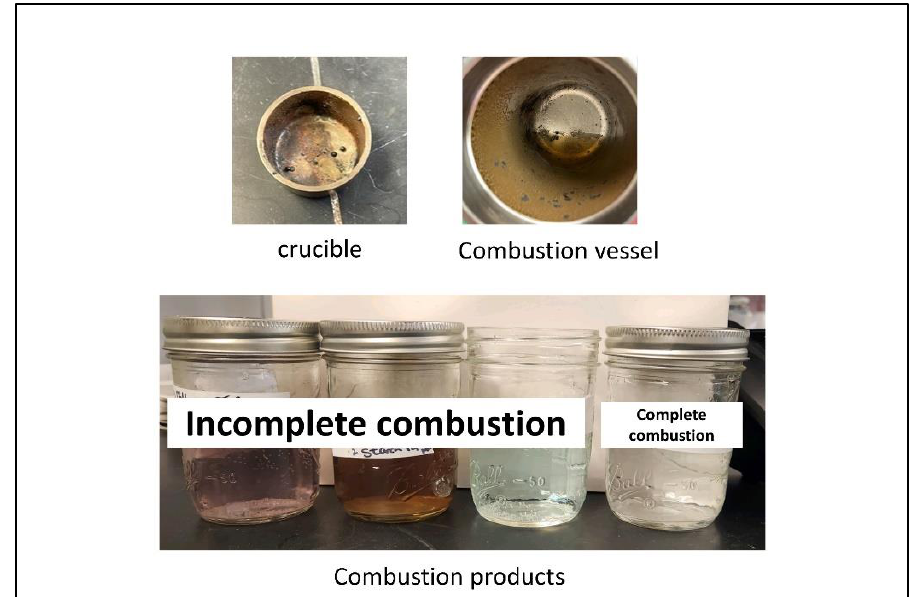
Figure 5. Sample of incomplete